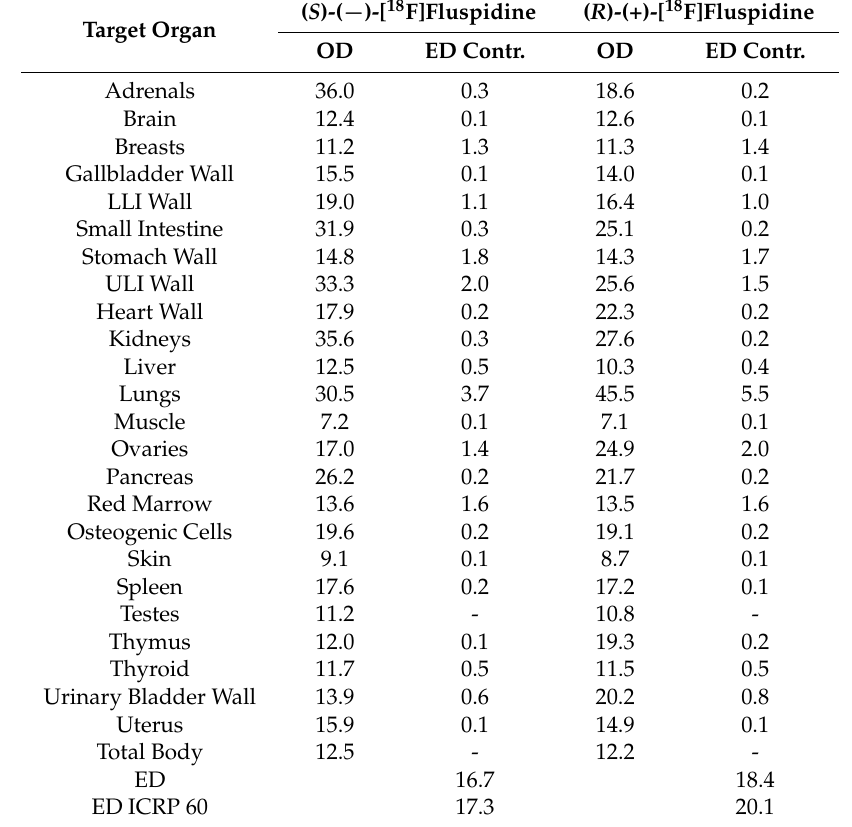
Table 2. OD and ED in µ Sv/MBq based on mouse organ harvesting after dissection and organ counting in a gamma-counter. The organ geometry data were scaled proportionately to human circumstances. ODs calculated for the adult male model (73.7 kg, implemented in